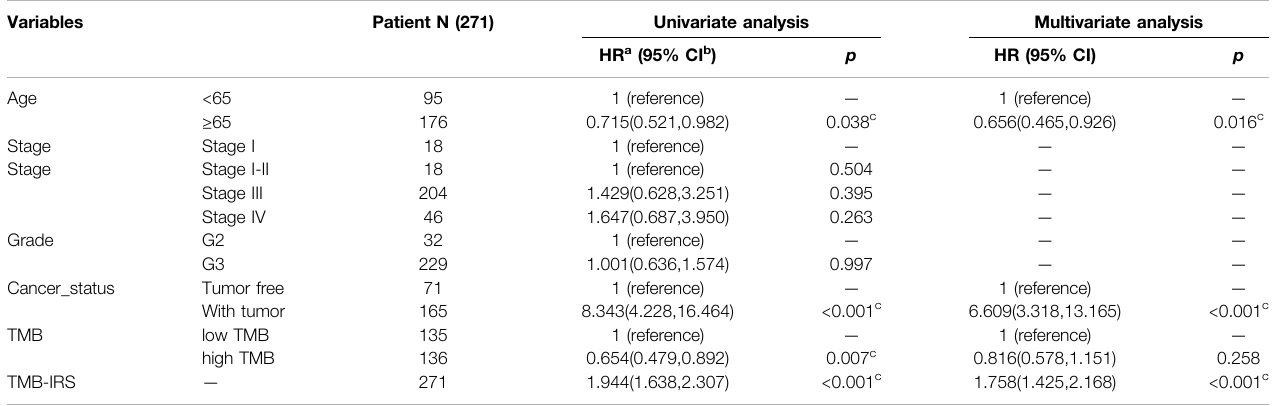
TABLE 1 | Univariate/multivariate Cox regression analysis of OC clinicopathological characteristics associated with OS.